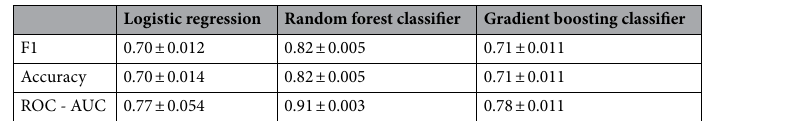
Table 1. 5-fold cross validation results for training data (mean ± standard deviation).